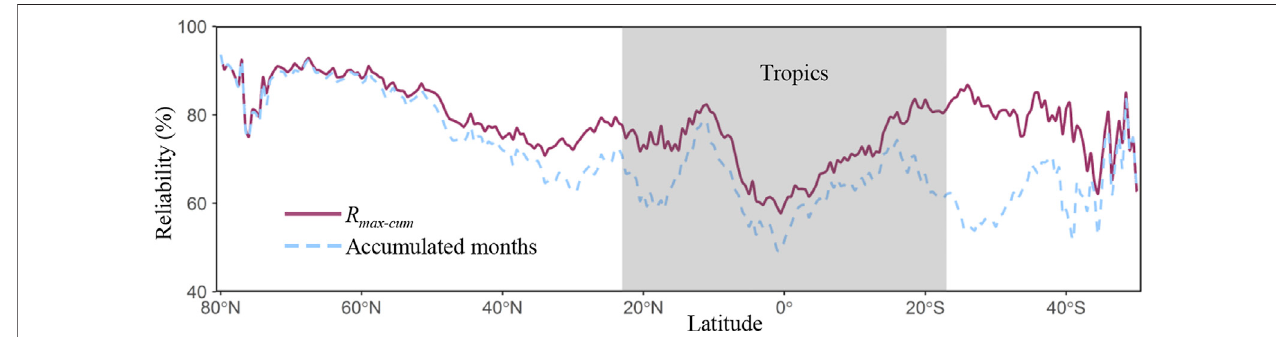
FIGURE 6 | Variability trend of reliability in R max-cum and accumulated months acquired from probability statistics across